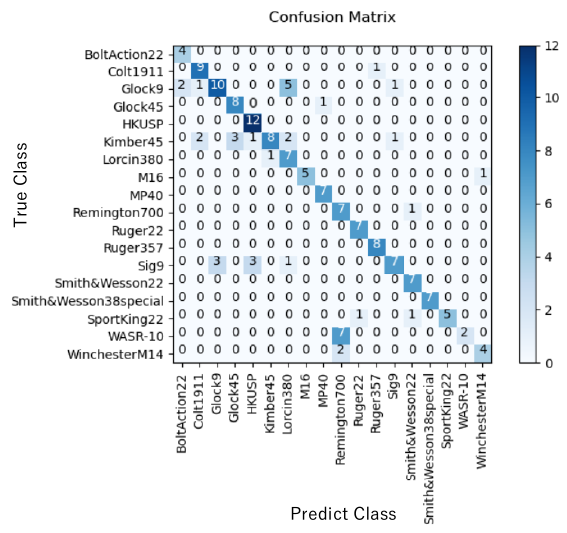
Figure 8. Validation set obfuscation matrix.